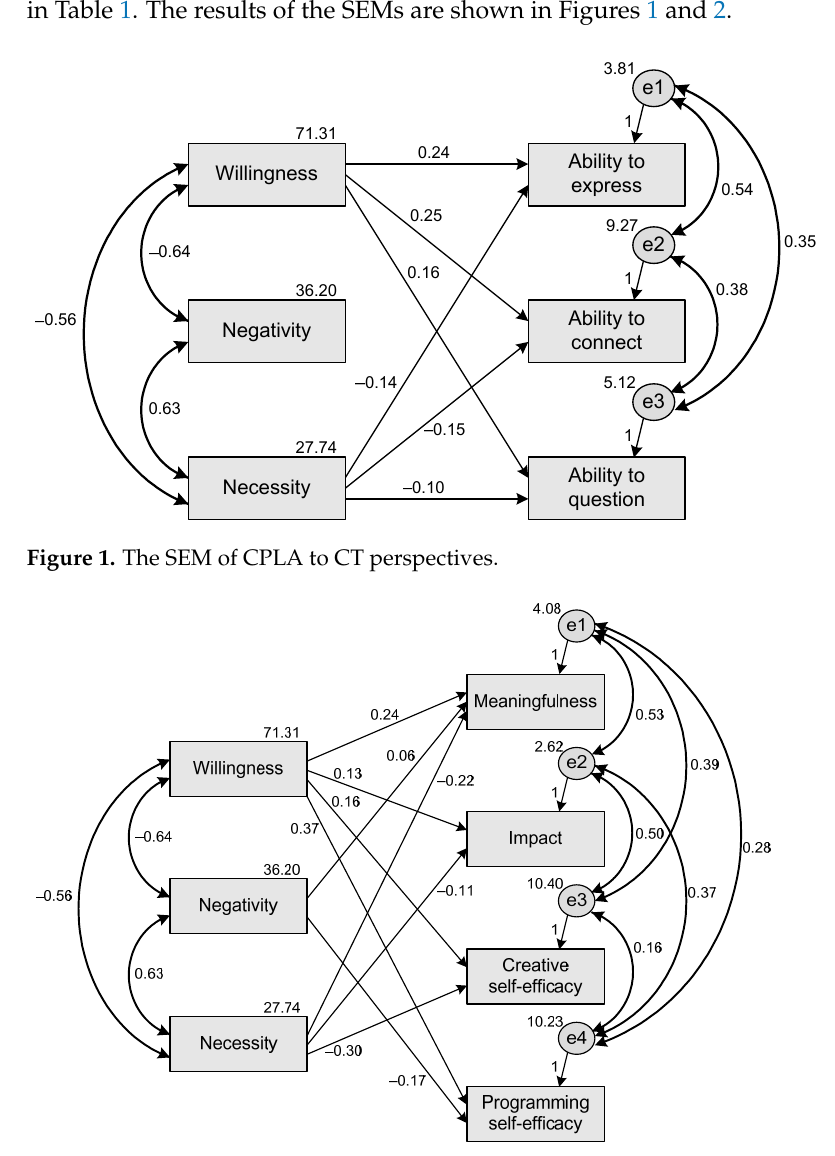
Table 5. Average variance extracted, square root of AVE, and matrix of correlations between factors for PES.